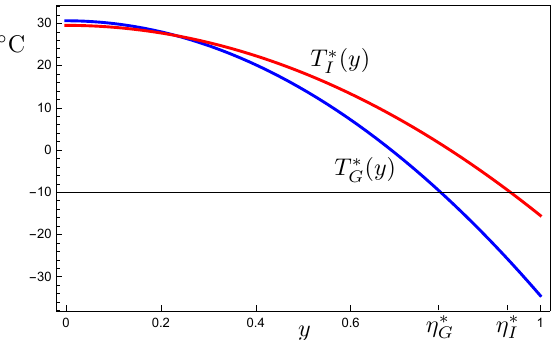
Figure 5. Equilibrium temperature distributions. Blue : D = D G = 0.3. Red : D = D I =